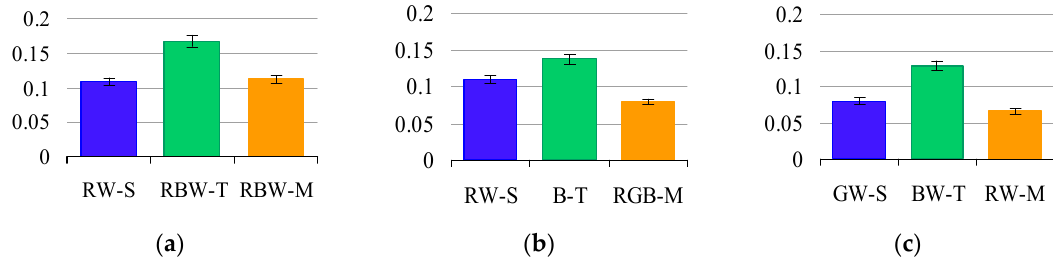
Figure 3. Comparison of fresh weight for the ( a ) highest ( b ) second highest and ( c ) third highest within CHO source –LED combination each CHO source. The X-axis the treatment combination, the Y-axis represents the number of PLBs, and the error bar represents the 95% confidence intervals. See text for meanings of abbreviations.